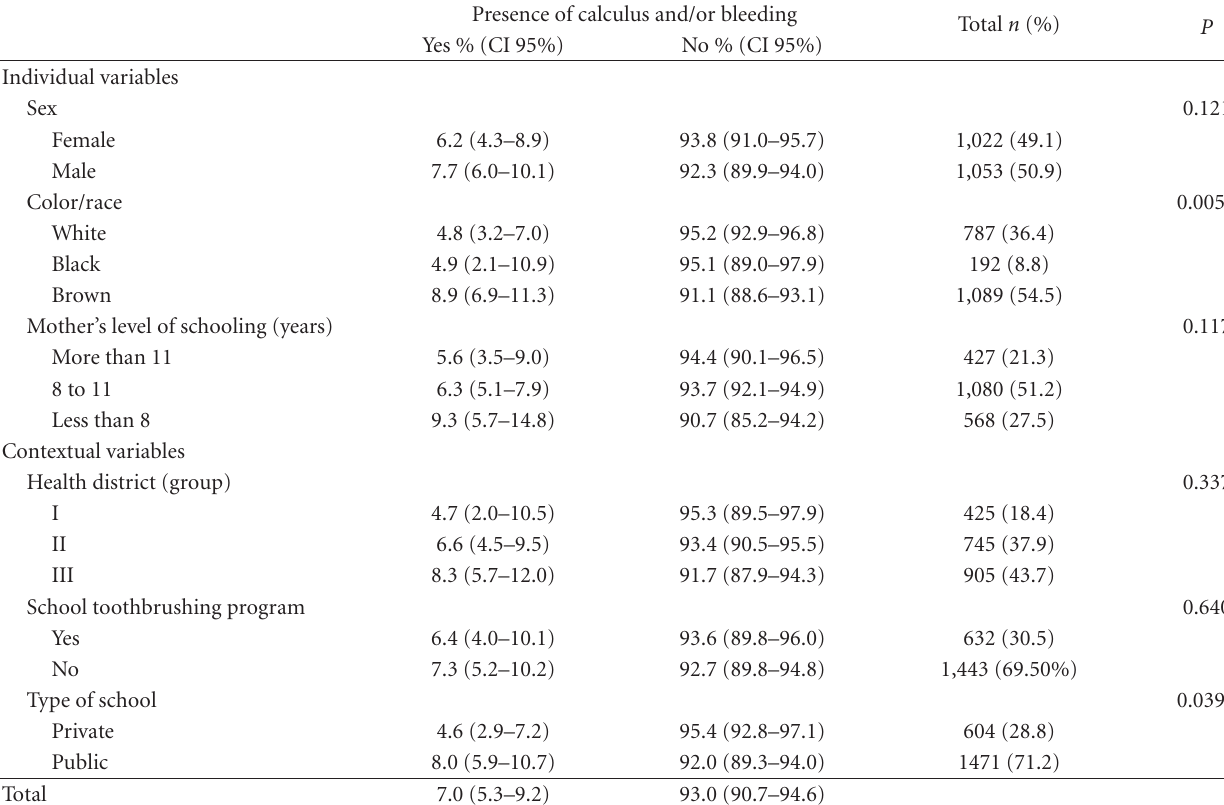
Table 1: Frequency distribution of periodontal conditions (calculus and/or bleeding), according to independent variables. 12-year-old schoolchildren, Goiania, Brazil,